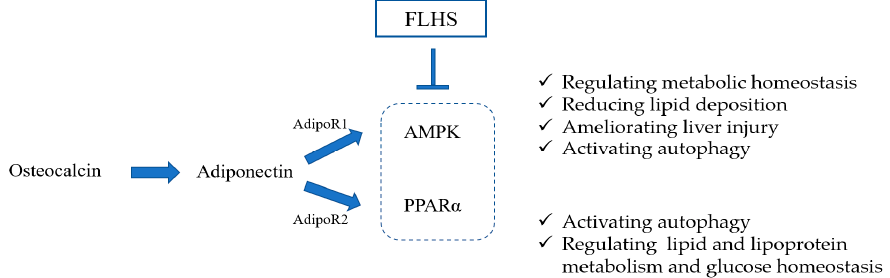
Figure 3. The diagram depicting the effects of osteocalcin on the pathways in the development of